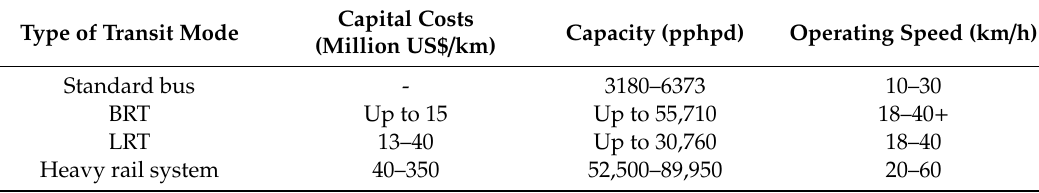
Table 2. Comparison of the public transport systems